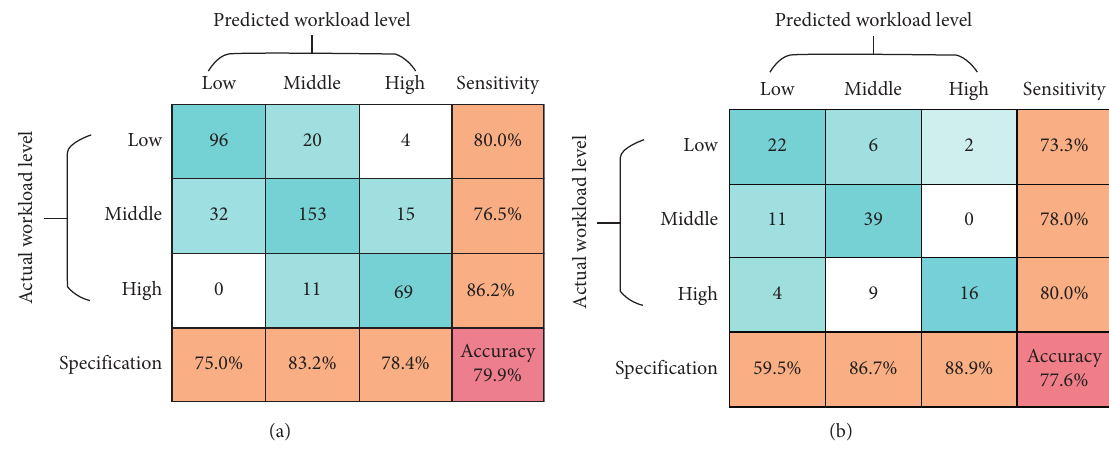
Figure 19: The confusion matrix of model classification result. (a) Training set identification accuracy (b) Test set identification